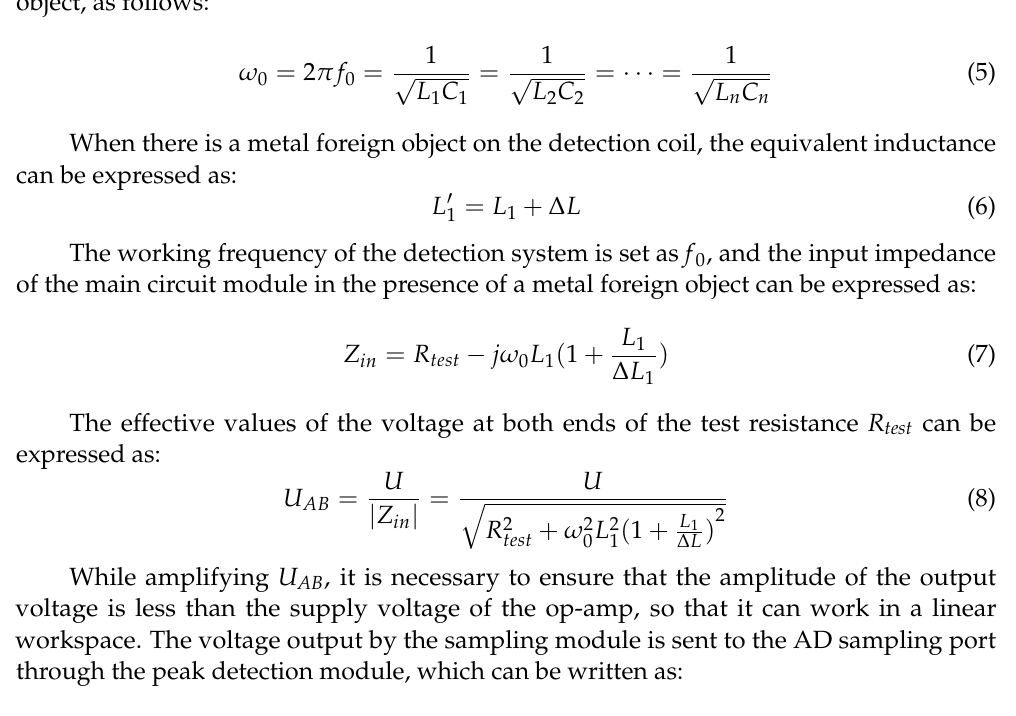
Figure 4. Equivalent circuit of MOD.